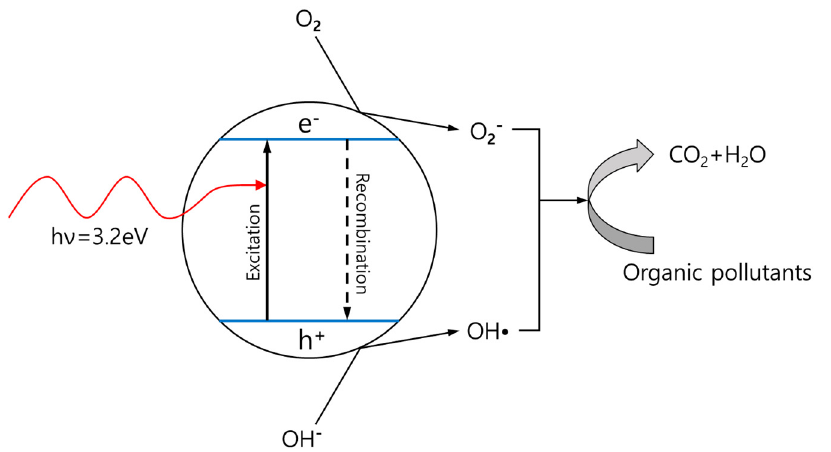
Figure 3. Schematic photoexcitation of metal oxides (TiO 2 , ZnO) during absorption of UV radia-